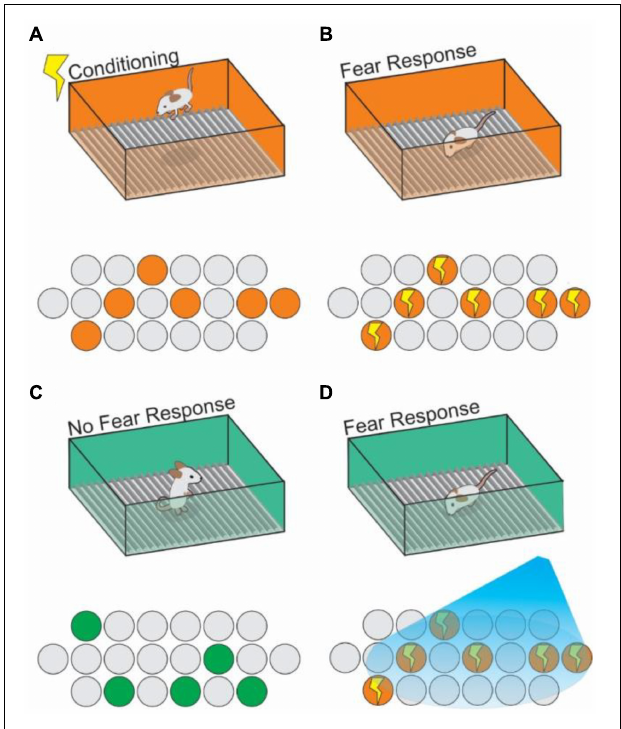
FIGURE 4 | Context engram reactivation in the hippocampus can trigger fear memories. (A) An animal receives a shock in Context A (orange box) and generates a context specific ensemble (orange circles) into which the shock memory is tied (contextual fear conditioning). (B) Upon re-exposure to context A, the previously generated neural ensemble is activated (indicated by lightning bolts), and a fear response to the context is triggered. Using active cell tagging, the previous contextual ensemble is marked with an opsin for later reactivation. (C) The animal explores a novel context (Context B; green box), with no association to the shock training, learns the context and generates a new contextual ensemble (green circles) and exhibits no fear response. (D) Optogenetic reactivation of the Context A ensemble causes reactivation of the fear memory associated with Context A in the setting of Context